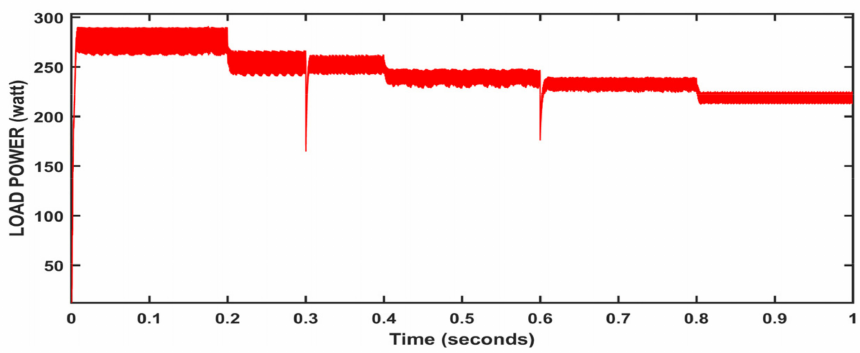
Figure 17. Algorithm performance under variable temperatures and varying